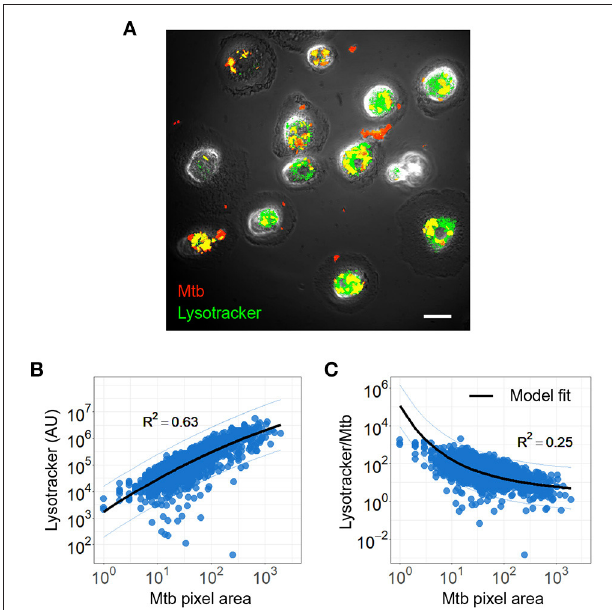
FIGURE 5 | Mycobacterium tuberculosis (Mtb) acidification per Mtb bacillus decreases with increasing Mtb aggregate size. (A) Image of lysotracker (green) colocalization with phagocytosed mCherry expressing Mtb (red). Scale bar is 20 µ m (B) lysotracker fluorescence as a function of total aggregate area. The linear regression line is shown in black ( R 2 = 0.63, p < 0.0001). (C) Ratio of lysotracker fluorescence to Mtb fluorescence as a function of Mtb area. Black line shows a model based on the surface area to volume ratio ( R 2 = 0.25, p < 0.0001, black